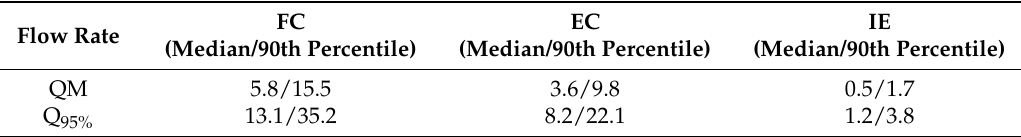
Table 4. Increase of FIB-number in the recipient (MPN/100 mL) by the WWTP discharge (median and 90%-Percentile for FC, EC and IE) calculated on basis of the mean flow rate (QM) or Q 95% .